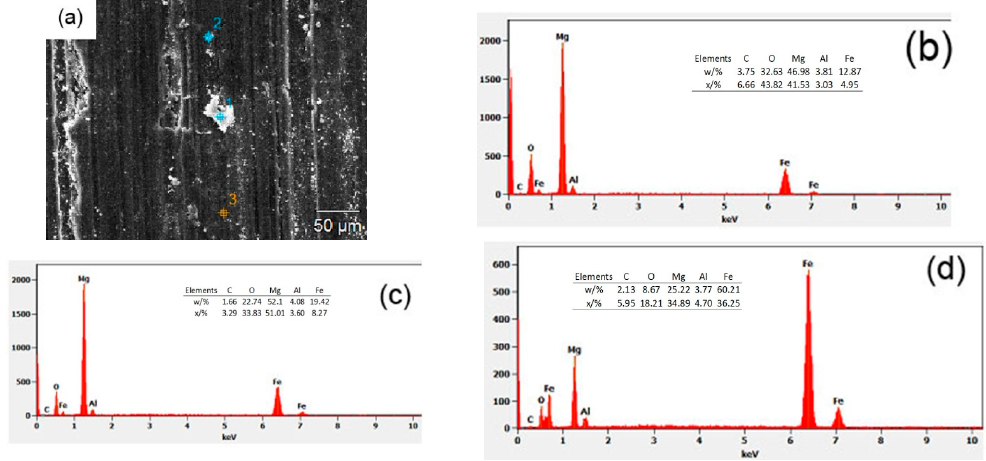
Figure 13. EDS analysis of wear debris ( a ) Location of points, ( b ) point 1, ( c ) point 2 and ( d ) point 3.